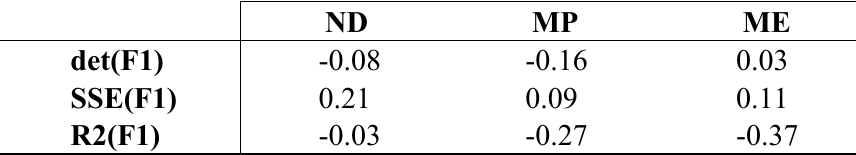
Table 1. Correlation coefficients for selected characteristics of emotional speech for two emotional speech databases (all presented variability descriptors are derived for the first formant